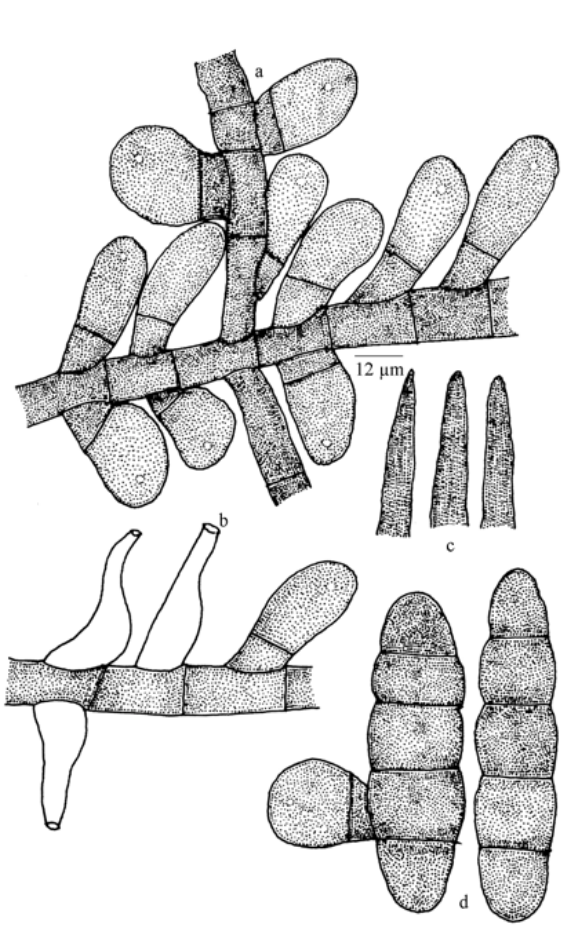
Figure 40. Meliola allophyli-serrulati a - Appressorium; b - Phialide; c - Apical portion of mycelial setae; d -